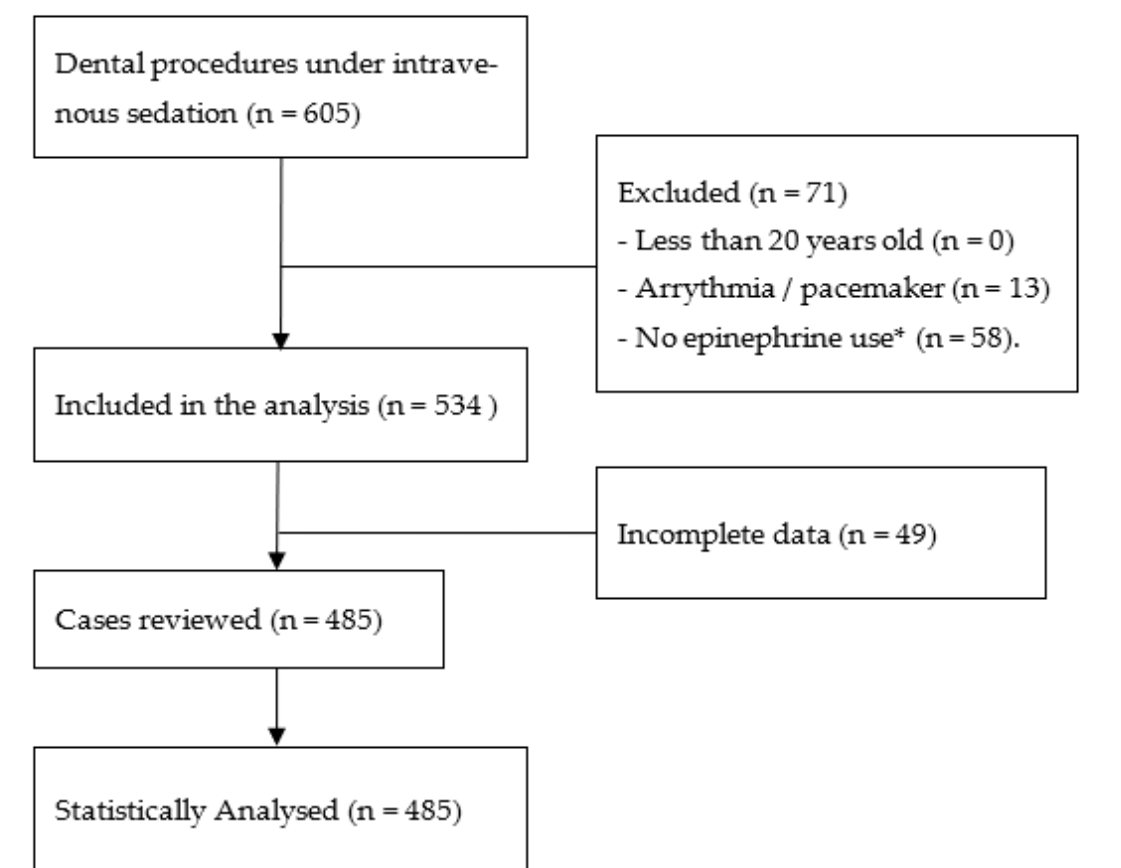
Figure 2. Flow chart of the case selection criteria. * Cases did not receive infiltration anesthesia and infiltration anesthesia without epinephrine.